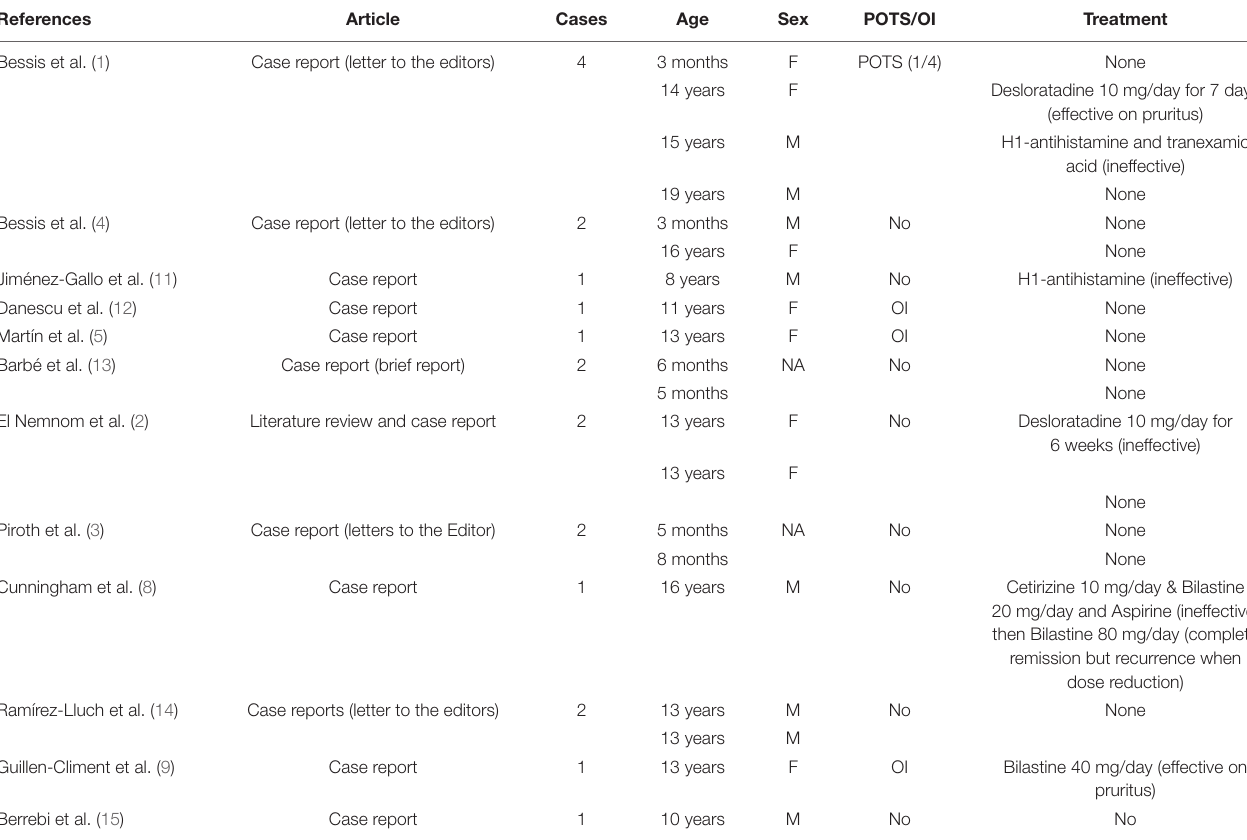
TABLE 1 | Bibliometric analysis of bier anemic spots, cyanosis, and urticaria-like eruption (BASCULE) syndrome